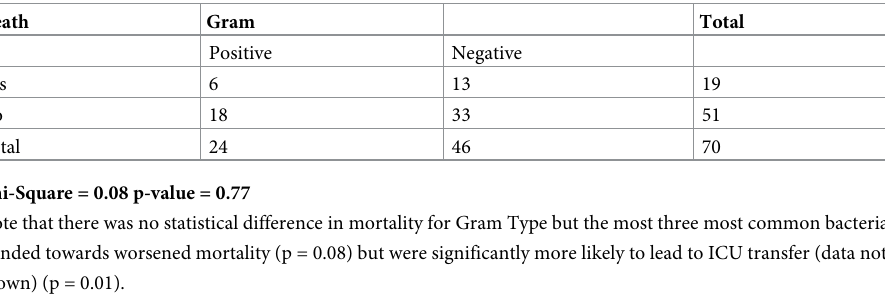
Table 3. Mortality and ICU stay comparisons for gram type among the most common organisms ( E . coli , K . pneu- moniae and Enterococcus spp) .